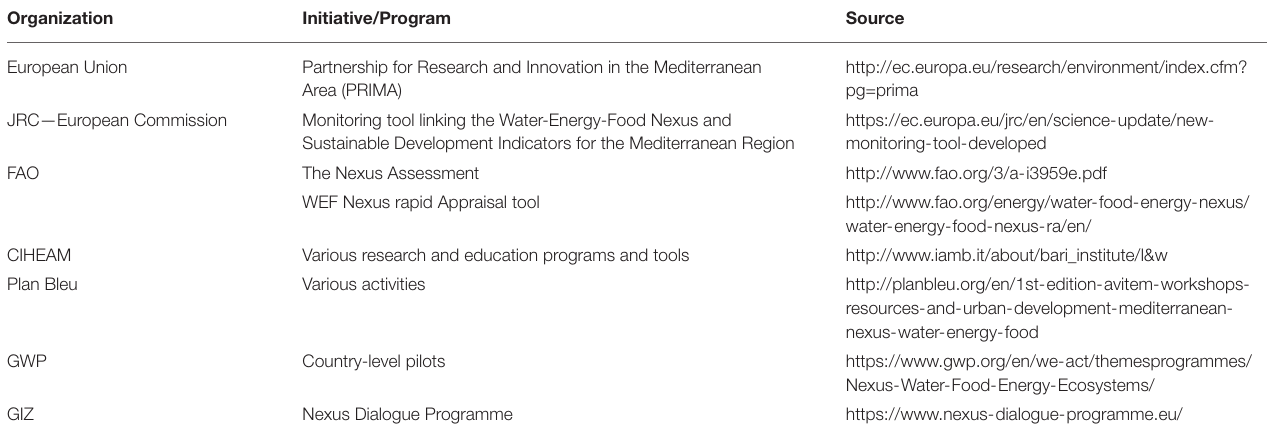
TABLE 1 | International WEF nexus initiatives and programs.